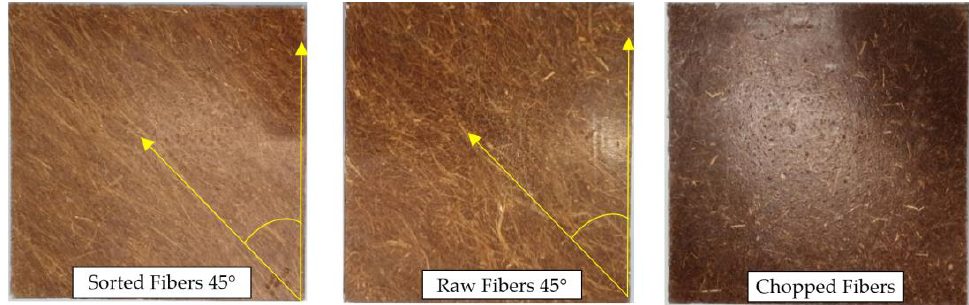
Figure 7. Examples of plates obtained with SF (oriented at 45°), RF (oriented at 45°), and CF (short ones).